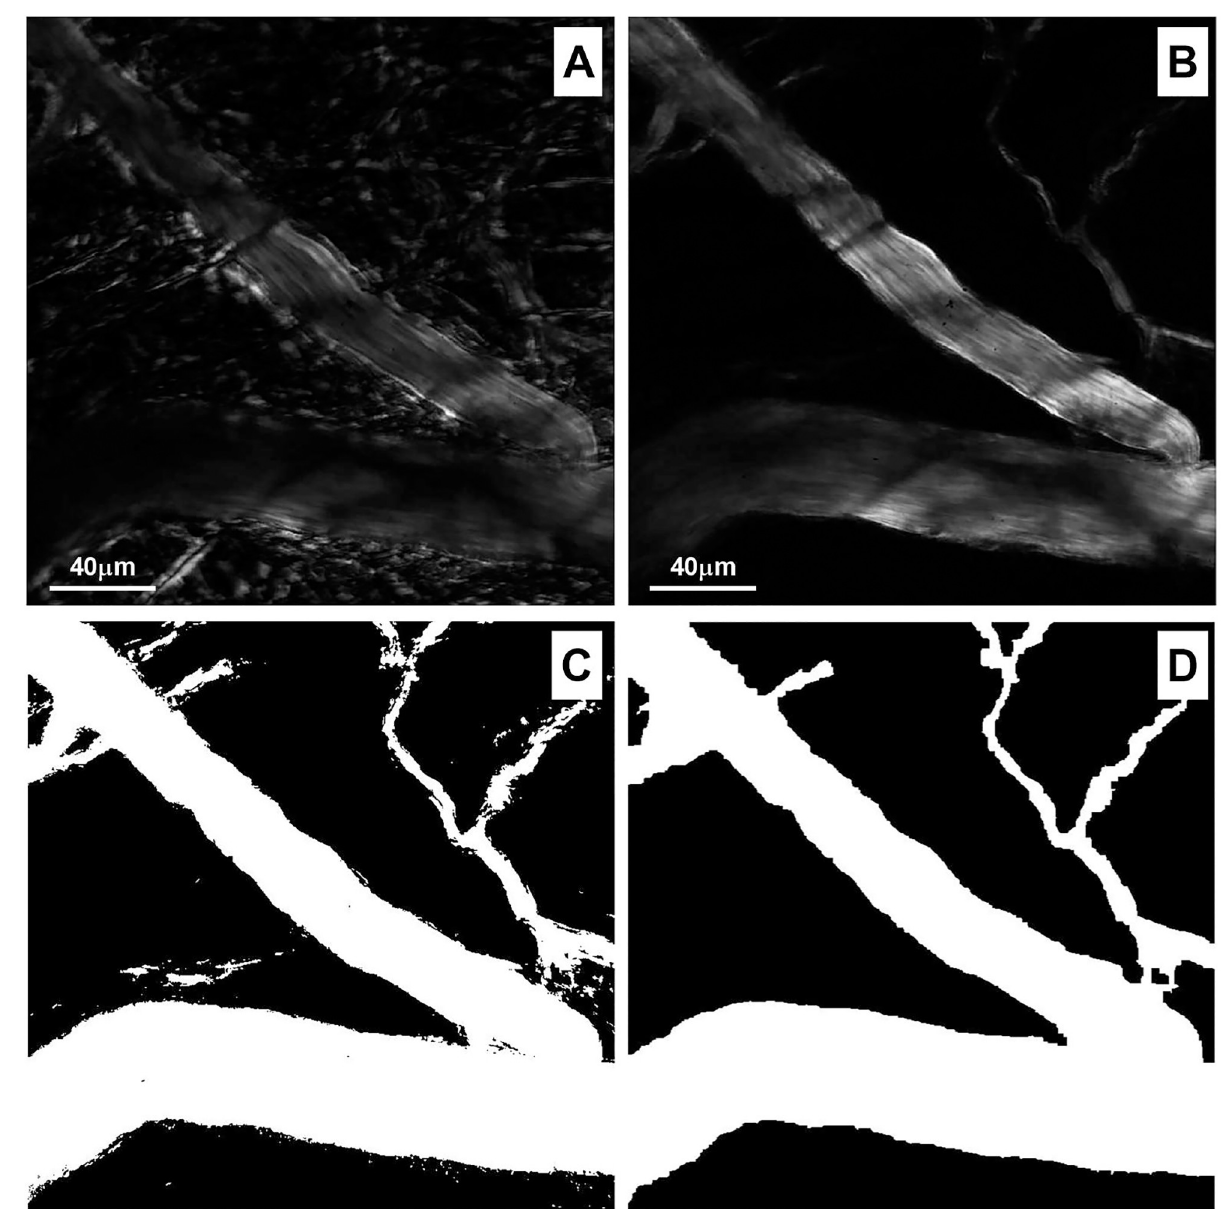
Fig 5. Enhancement of image. (A) The rest interval and analysis of variance improved the outline of the blood vessel. (B) Image of arteriole without rest interval. (C) Binarization of the image (D) A morphological filter applied to the binarized image.